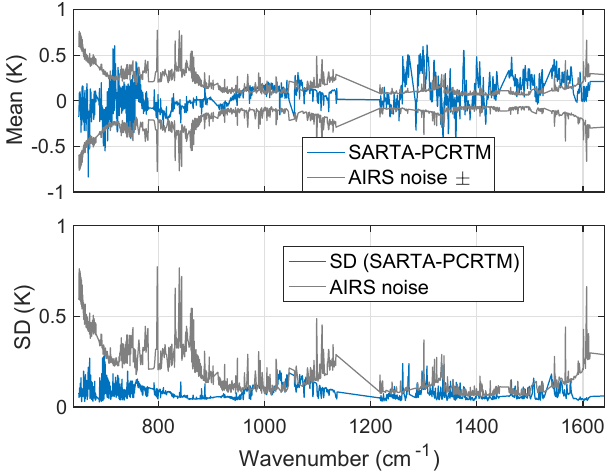
Figure 3. Biases and standard deviations between 1000 TwoSlab computations using SARTA and PCRTM. See the text for details on these double-difference